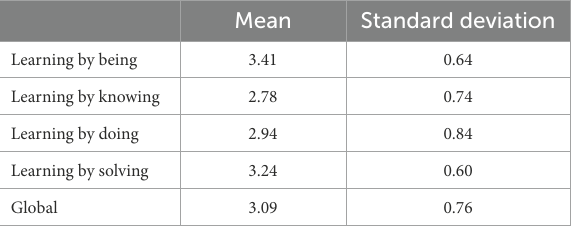
TABLE 3 Analysis by dimensions of the questionnaire